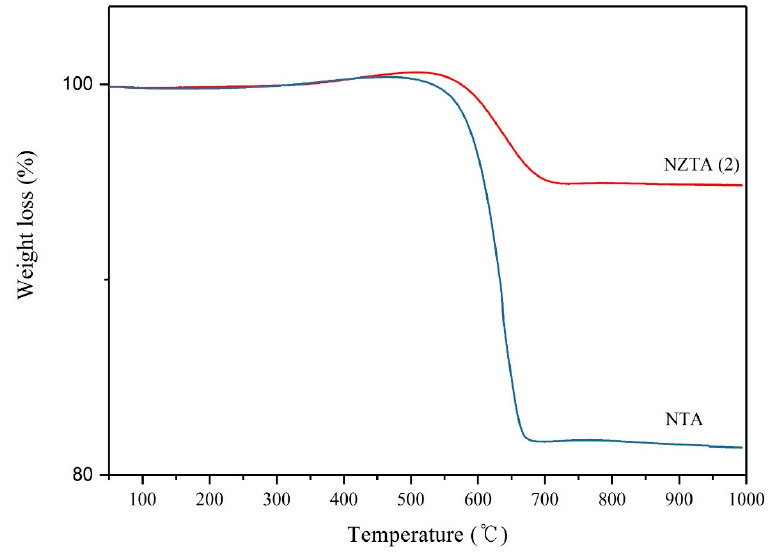
Figure 11. The TGA profiles of the spent catalysts (NATA (2) and NTA) reacted for 50 h in the DMR.